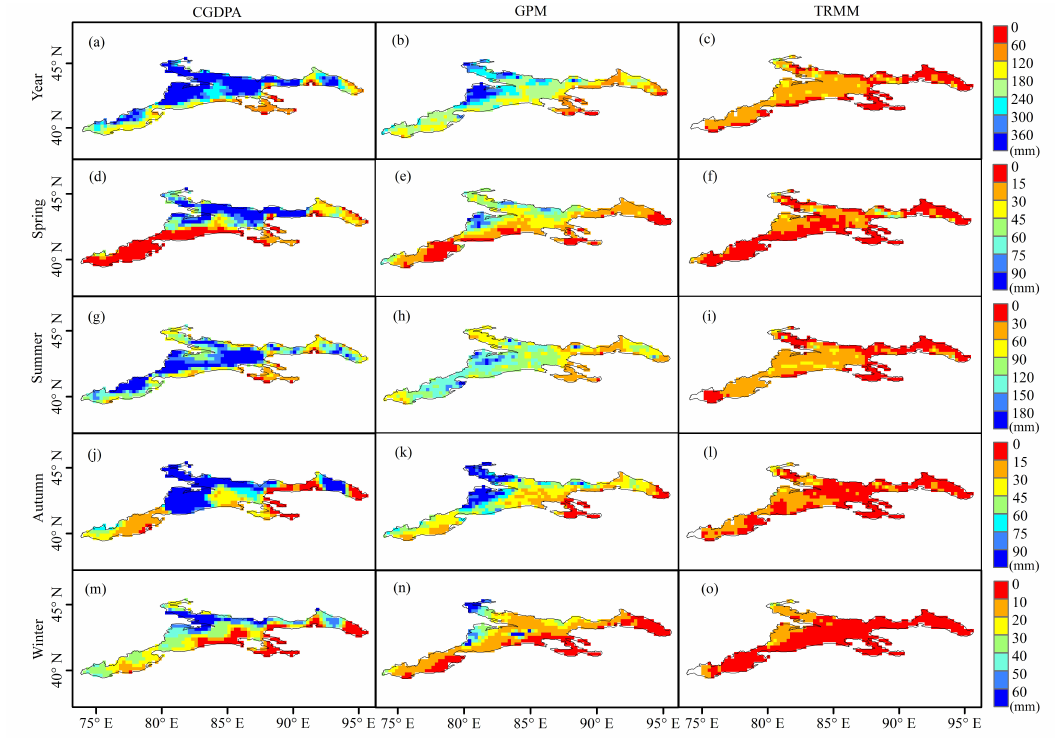
Figure 2. Spatial distribution of annual and seasonal total precipitation (mm) by the China Gauge-based Daily Precipitation Analysis (CGDPA) ( a , d , g , j , m ), the Global Precipitation Measurement (GPM) ( b , e , h , k , n ), and the Tropical Rainfall Measuring Mission (TRMM) ( c , f , i , l , o ) in the Tianshan Mountains (TSM) of China from 1 April 2014 to 31 March 2015. Year ( a – c ), spring ( d – f ), summer ( g – i ), autumn ( j – l ), winter ( m – o